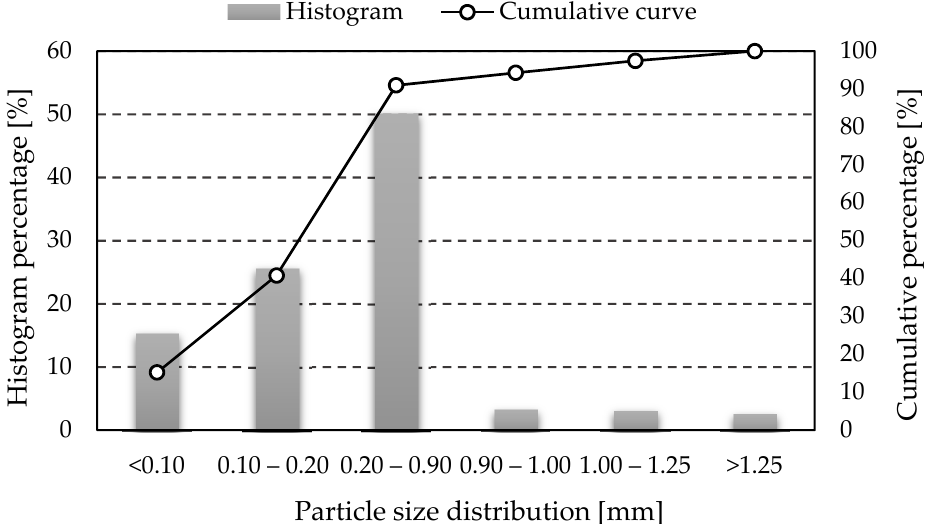
Figure 2. Histogram of particle size distribution and cumulative particle size distribution curve for the construction sand used in the investigation.